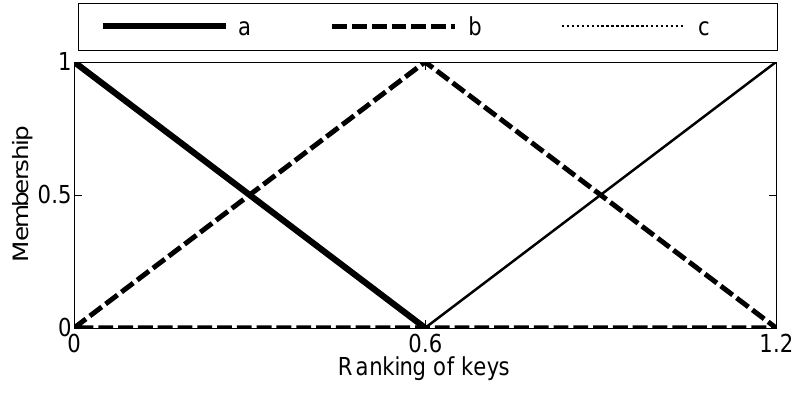
Fig. 4. Output membership functions for category keys